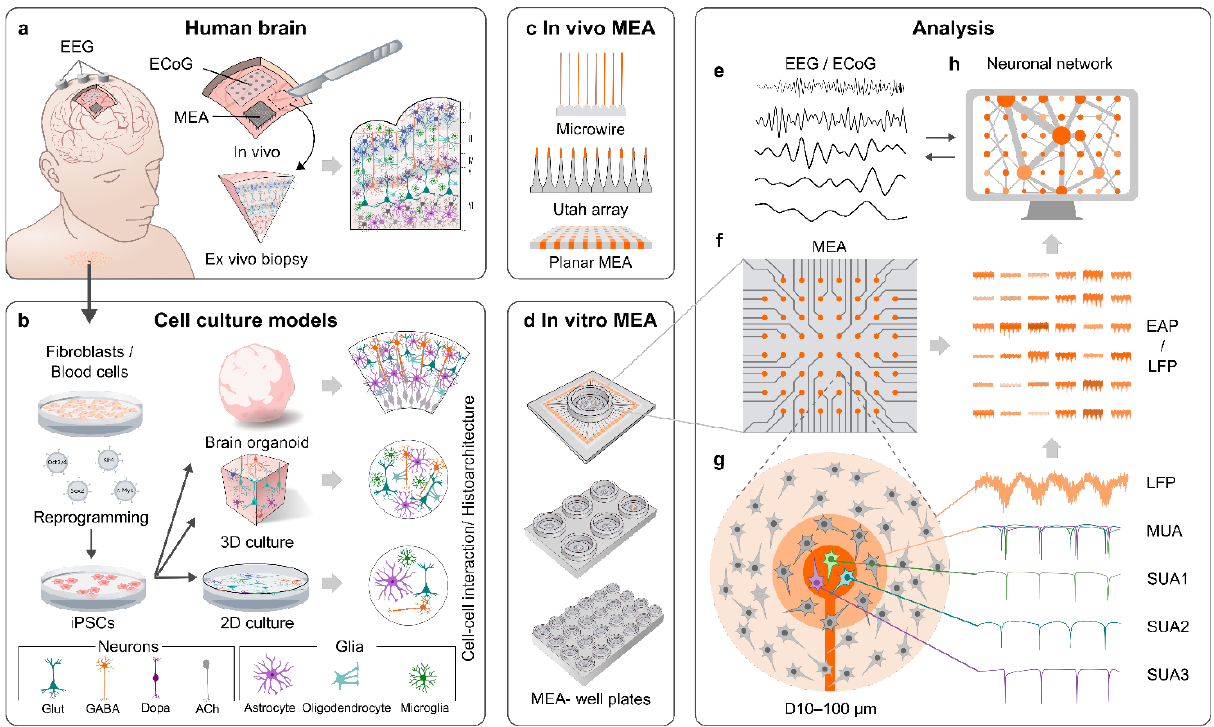
Figure 1. MEA recordings of the human brain and corresponding hPSC-derived models. ( a ) Neuronal network activity can be recorded directly through the skull and skin using EEG or on the surface of the brain using ECoG or MEA. It is possible to attain ex vivo biopsies of the living human brain during brain surgeries for electrophysiological measurements. ( b ) Another option to gain access to human neuronal networks is to first reprogram human somatic cells into hiPSCs, which are then differentiated into different cell types of the brain (Glut = glutamate, GABA = gamma - aminobutyric acid, Dopa = dopamine, Ach = acetylcholine). Current methods enable differentiation of the iPSCs into 2D, 3D, or even self- organizing organoid models of the brain. ( c ) MEA formats, such as microwires and Utah arrays, have been used to record the activity of the human brain in vivo. ( d ) Various MEA systems for recording in vitro cell cultures are also commercially available. ( e ) The network data provided by EEG and ECoG are filtered similarly as the local field potential (LFP) data from MEA. ( f,g ) Electrode data from MEAs can be filtered for LFPs or extracellular action potentials (EAPs). ( g ) A single electrode can detect EAPs from multiple neurons in its vicinity. The resulting data are referred to as multi-unit activity (MUA), but if the EAPs from different neurons are discriminated based on the waveform shape, the resulting data are referred to as single-unit activity (SUA). ( h ) Simultaneous measurement of neuronal activity from multiple electrodes at different locations across the sample on MEA allows the analysis of the functional connectivity in the neuronal network.